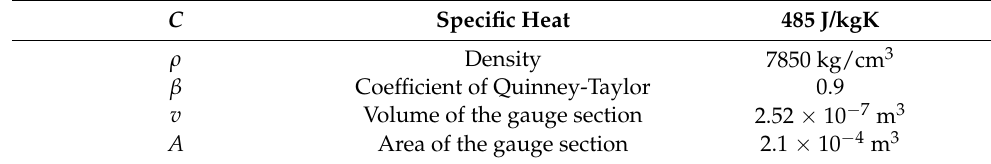
Table 4. Parameters used in the temperature rise formula.